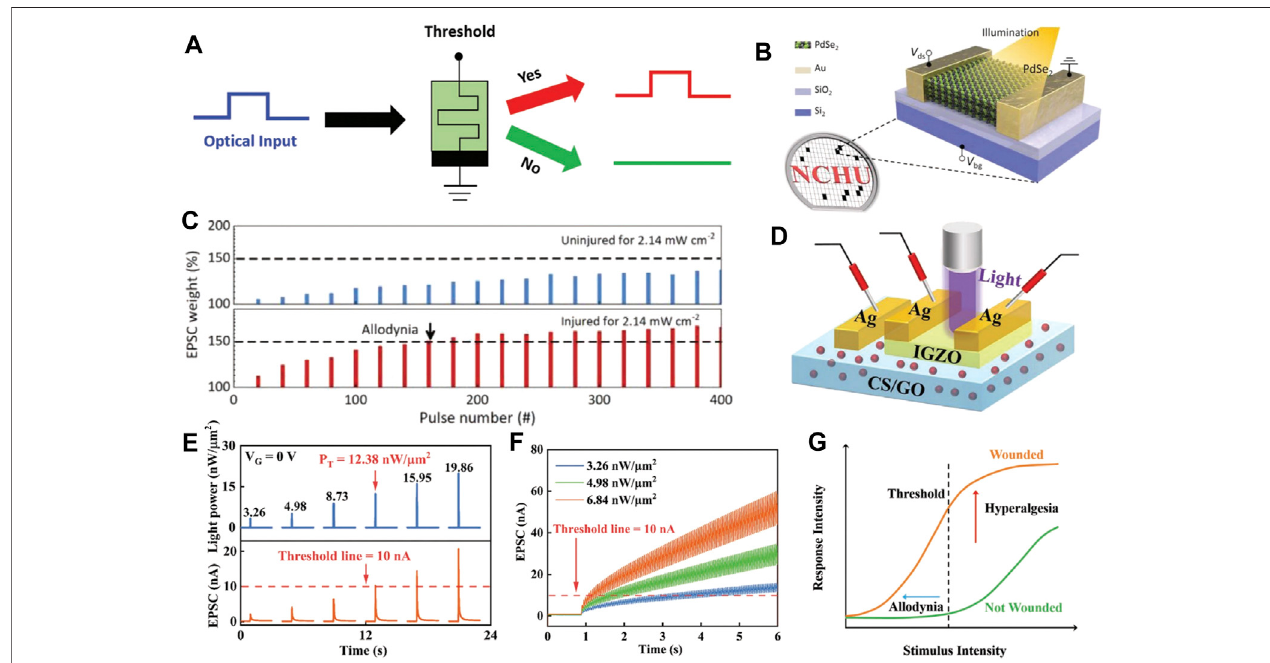
FIGURE13|(A) Threshold-intensity-dependentphotoresponseofthephotodetector(adaptedfromKumaretal.,2019a). (B) 3Dschematicdiagramofatransistor underlaserirradiation. (C) Tosimulatetheallodyniacharacteristicofsensitizationfunction,EPSCweightsforaseriesofinnocuousstimuliwereobtainedinbothuninjured and injured states (adapted from Li et al., 2021). (D) The structure illustration of the transistor. (E) The intensity-dependent threshold characteristic (F) Threshold characteristic and no-adaptation characteristic. (G) Schematic diagram of allodynia and hyperalgesia (adapted from Ke et al.,